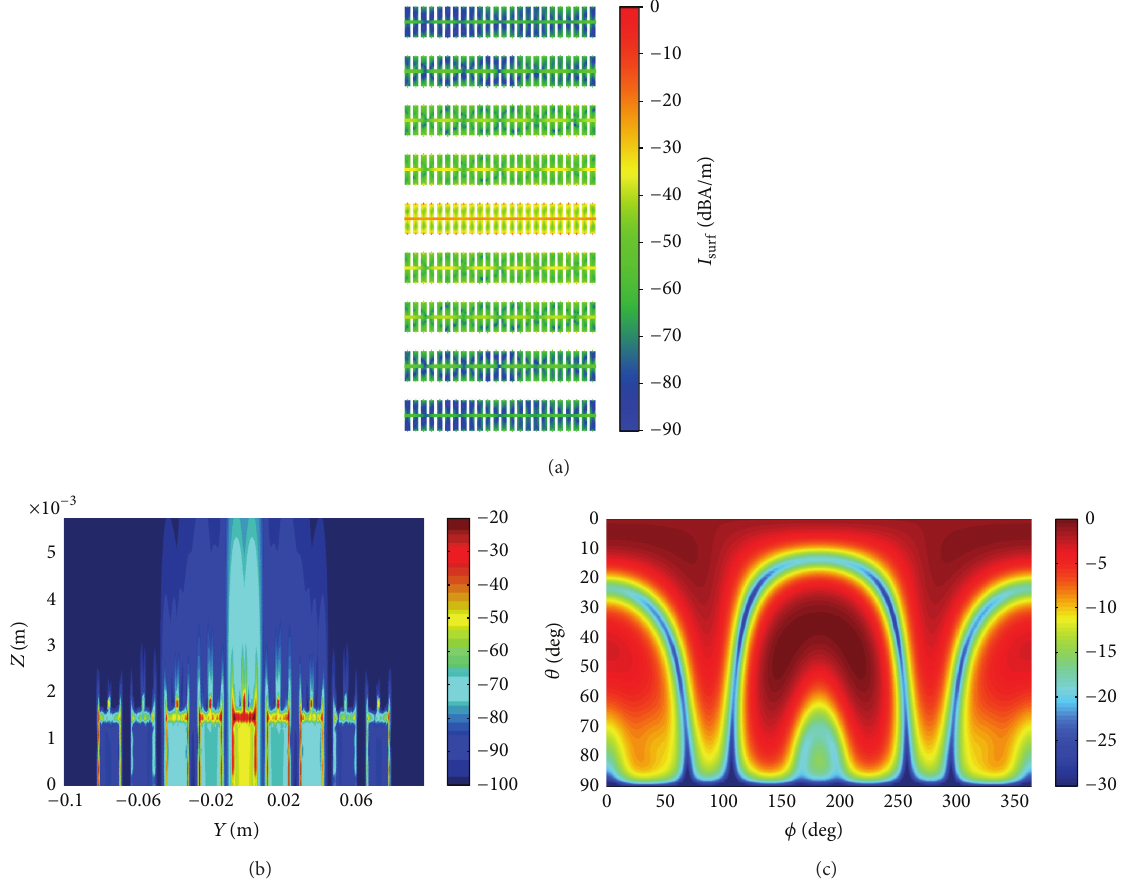
Figure 6: 9 × 24 -element 2D array, all “on” switch configuration, results at 𝑓 = 6.5 GHz: surface current distribution (a) and electric field distribution in a plane orthogonal to the microstrip line near field (b) and far field (c). Table 1: Comparison between MoM and SFX numerical efforts (for 1 frequency point). Single precision Double precision Double precision 24-element array 9 × 24 -element